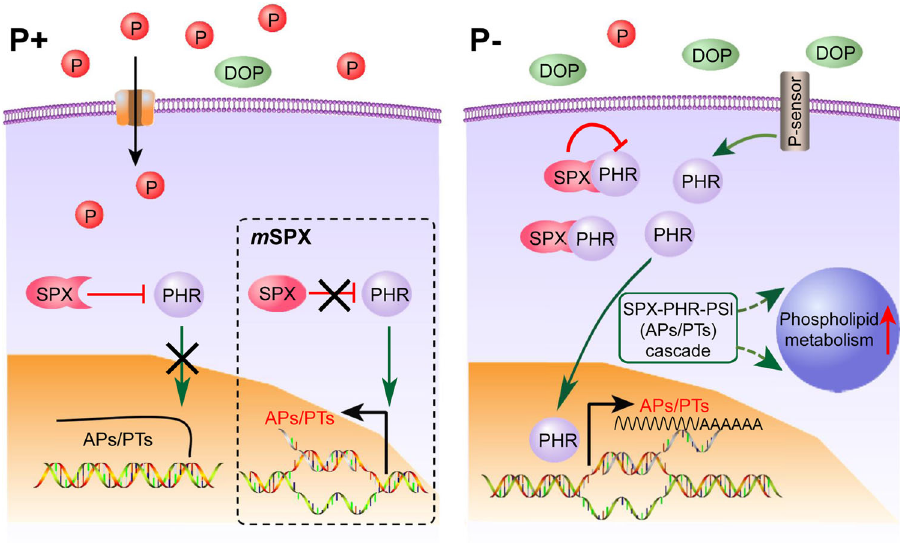
Fig. 5 Schematic of action mode of the SPX-PHR-PSI regulatory cascade under P + and P − conditions. The P + condition is shown on the left, in which regulation functions in the SPX mutant is shown in the inset, whereas the P − condition on the right. Positive and negative regulations are indicated by arrows and fl at-ended lines, respectively. The vertical red arrow indicates upregulation. Crosses depict blockage of the